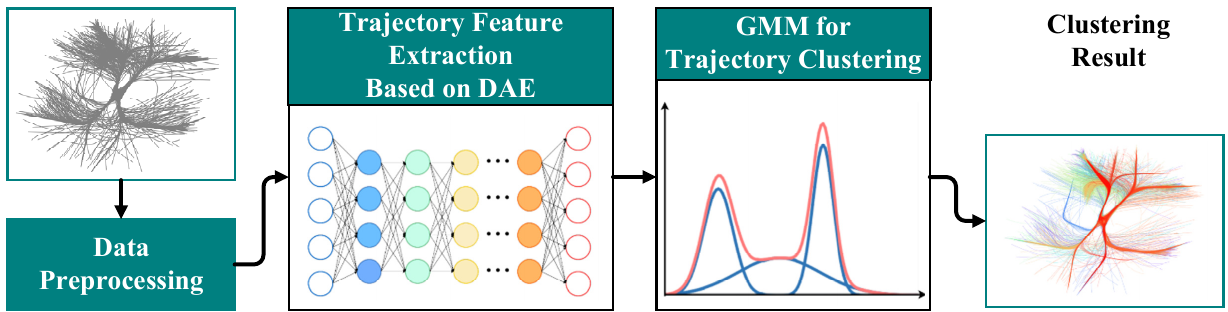
Figure 1. The flow of our proposed framework.